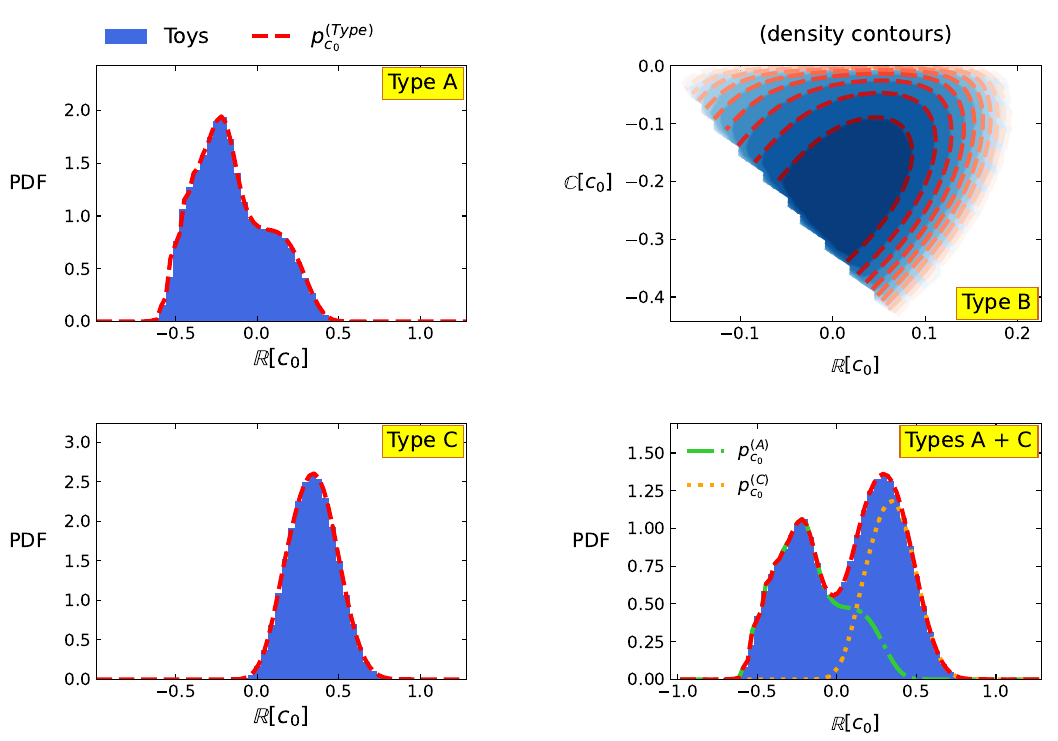
Figure 25: Densities of c in the three different event categories. Type A and C events 0 fall on the real axis whilst Type B events fall in the complex